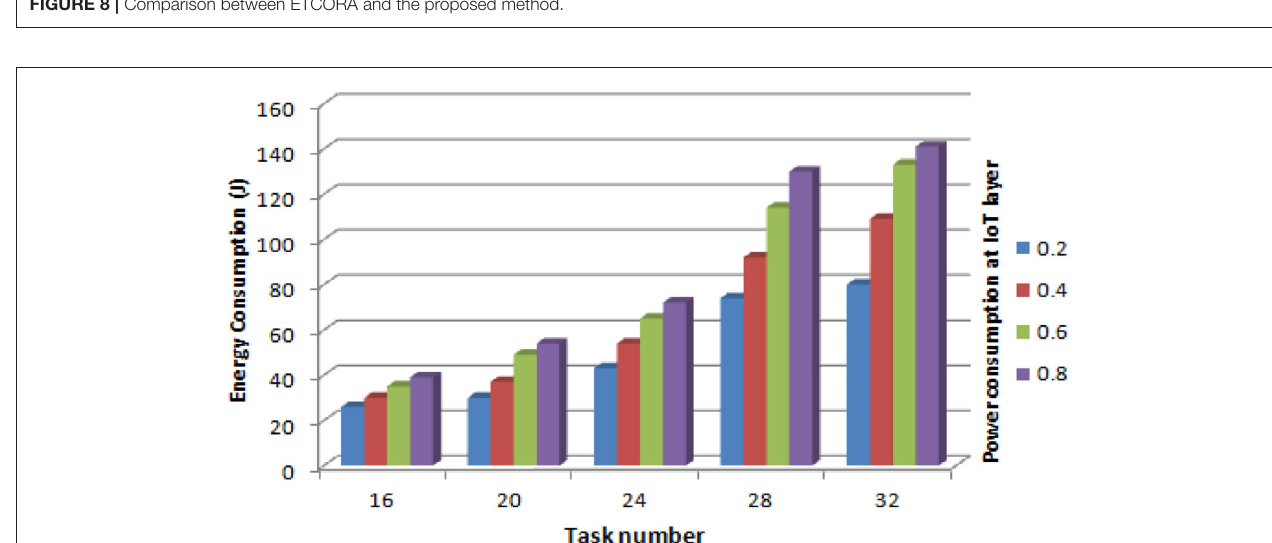
FIGURE 9 | Impact of power consumption at IoT